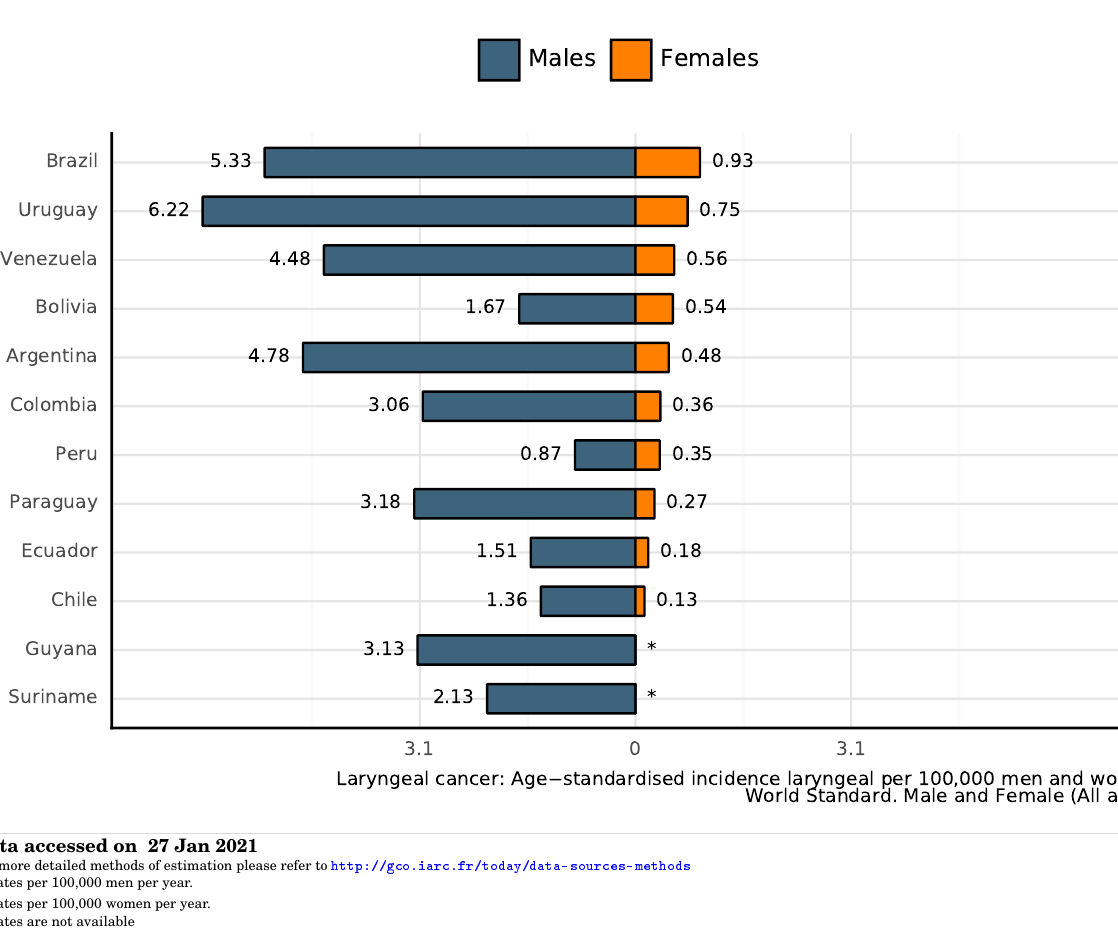
Figure 100: Age-standardised incidence rates of laryngeal cancer of Peru (estimates for 2020)